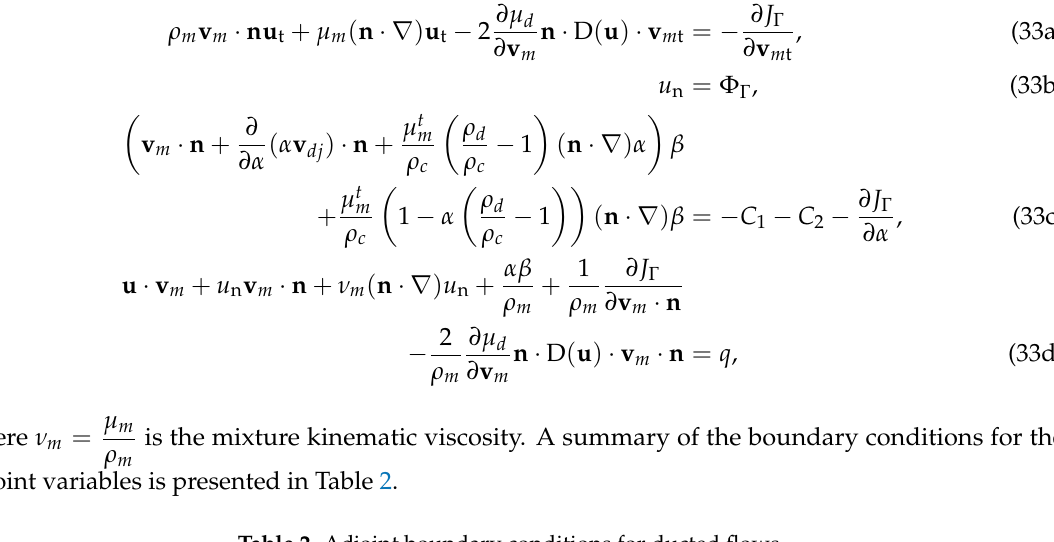
Table 2. Adjoint boundary conditions for ducted